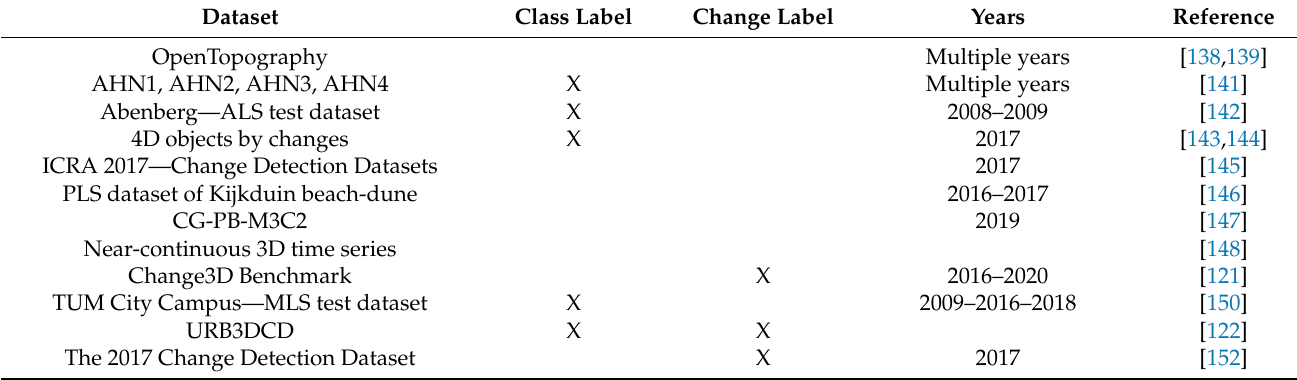
Table 3. Summary of the existing